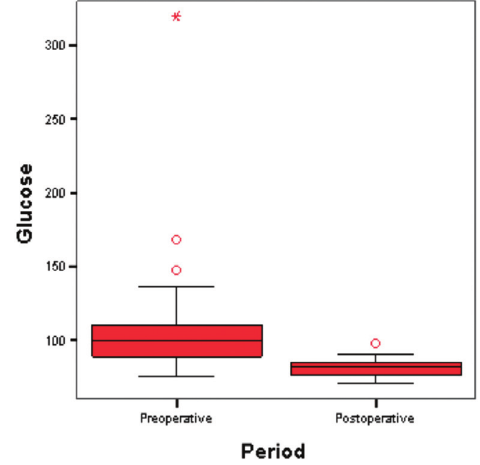
Figure 3 - Fasting plasma glucose levels (preoperative and